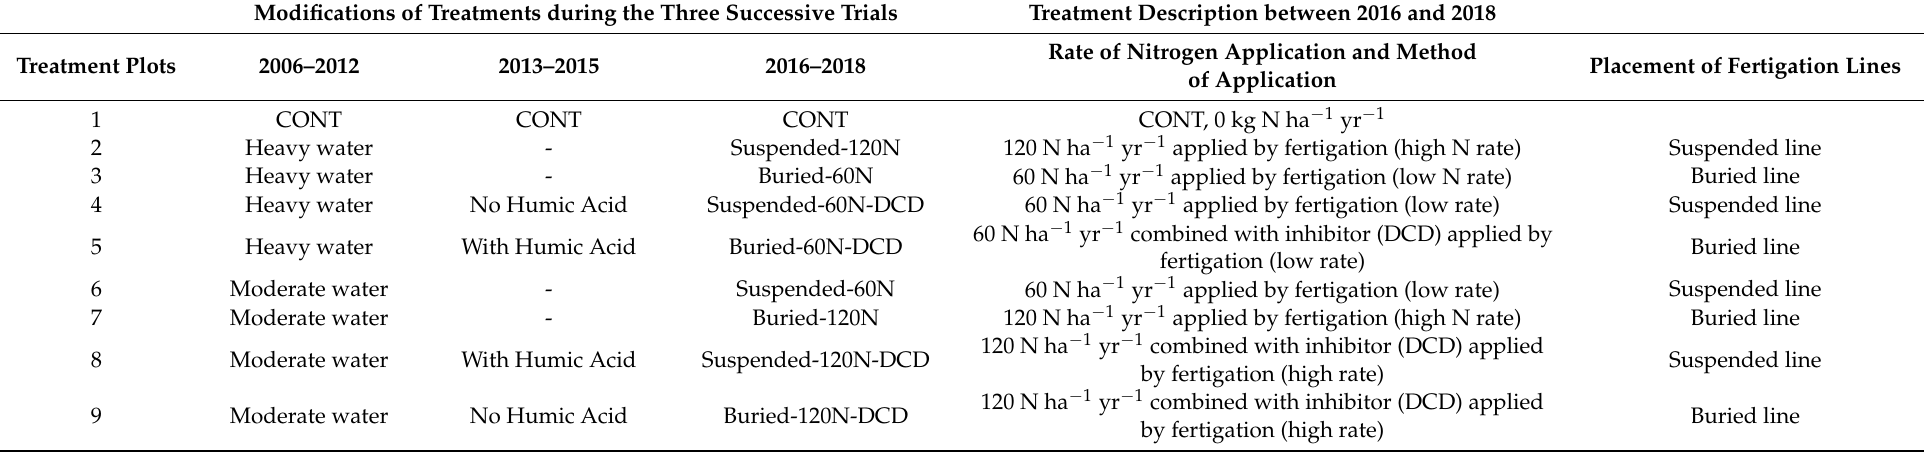
Table 1. Description of experimental treatments including combinations of annual nitrogen application rates and nitrification inhibitor (2-chloro-6-(trichloromethyl)-pyridine (Nitra-pyrin), di-cycandiamide (DCD)) and methods, and placement of irrigation/fertigation lines in the long-term blueberry